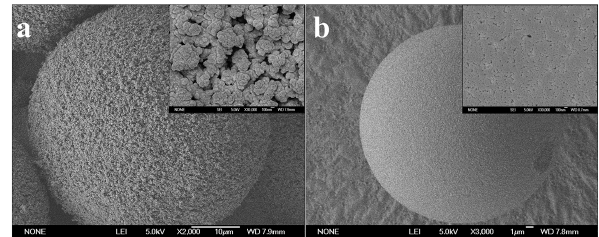
Figure 1. SEM images of PST-300 ( a ) and PST-14 ( b ) microspheres.